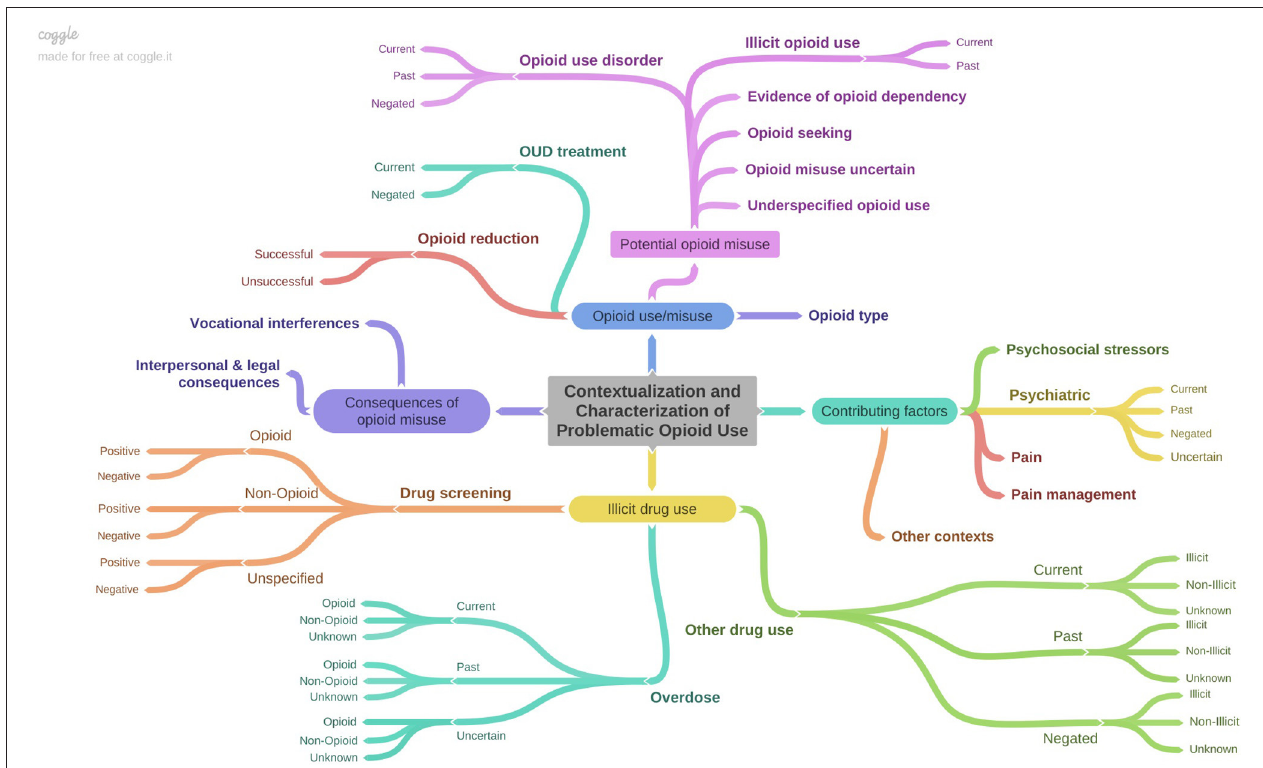
FIGURE 1 | Depiction of annotation schema characterizing OUD-related information contained in discharge summaries. Figure created using Coggle